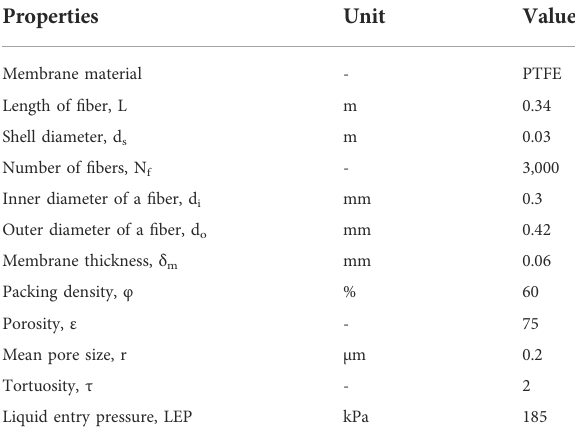
TABLE 1 Properties of the hollow fi ber membrane for DCMD (Cheng et al., 2008; Lee et al.,